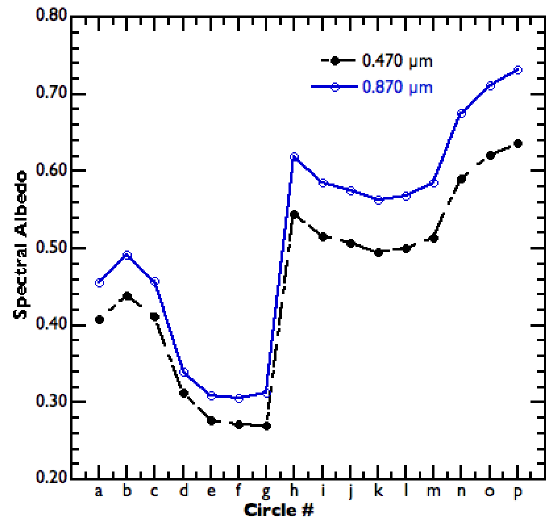
Figure 7. Spectral albedo (with atmosphere) for all 16 cases at λ = 0.470µm and λ =